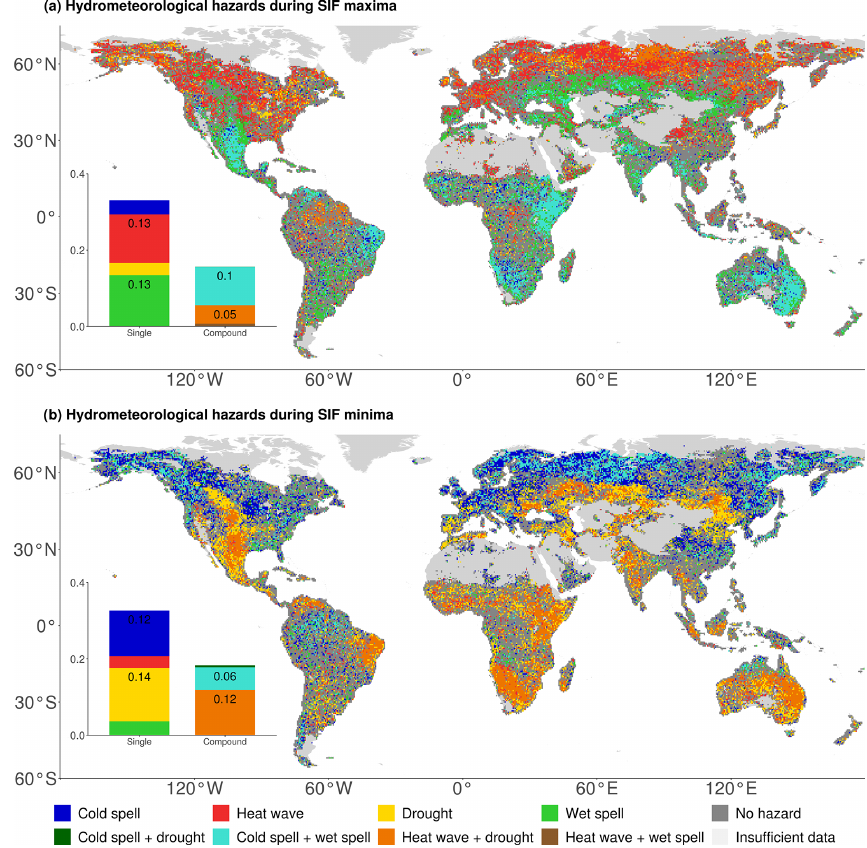
Figure 2. Hydrometeorological hazards co-occurring with (a) SIF maxima and (b) SIF minima. Colours denote the type of hydrometeoro- logical hazard. Bar plots indicate the area affected by each hazard type relative to the total study